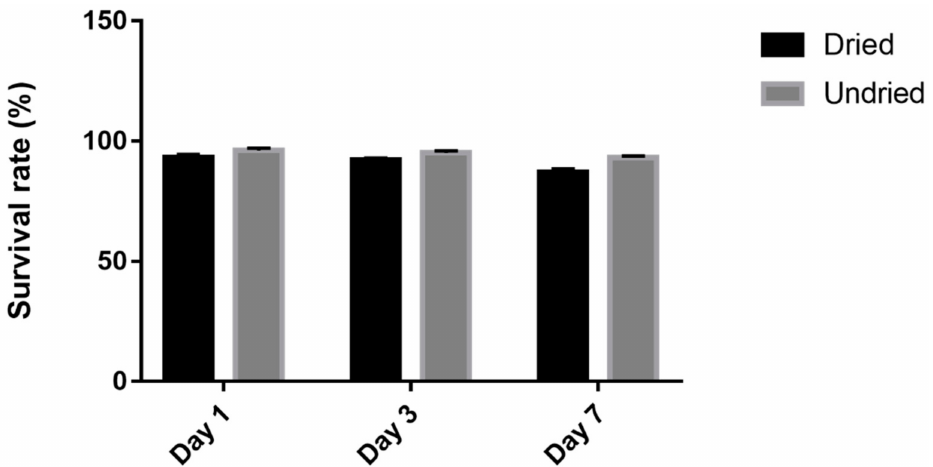
Figure 2. Survival rate of L. casei K17 on feed with dried and undried storage for 7 days. Values (mean ± SE, n =